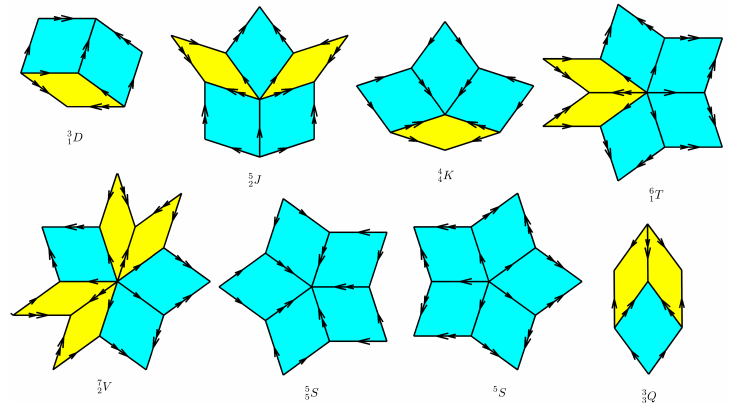
Figure 11. Eight distinct types of vertices in the Penrose tiling, as shown in Figure 2c, denoted by